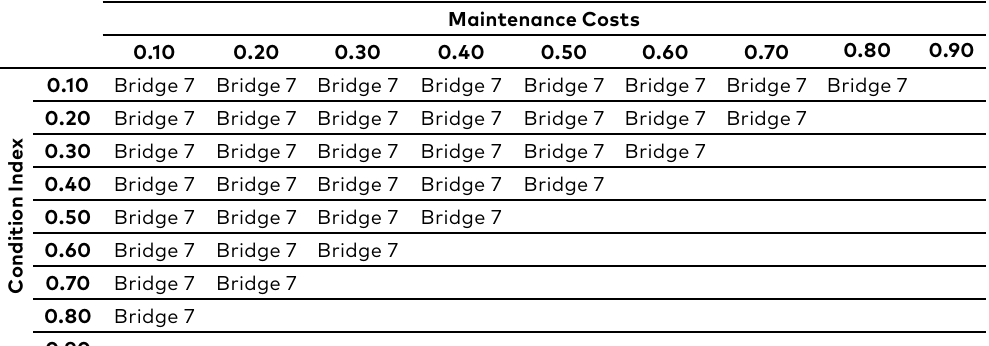
Table 3. Condition Index and Maintenance Costs sensitivity analysis Maintenance